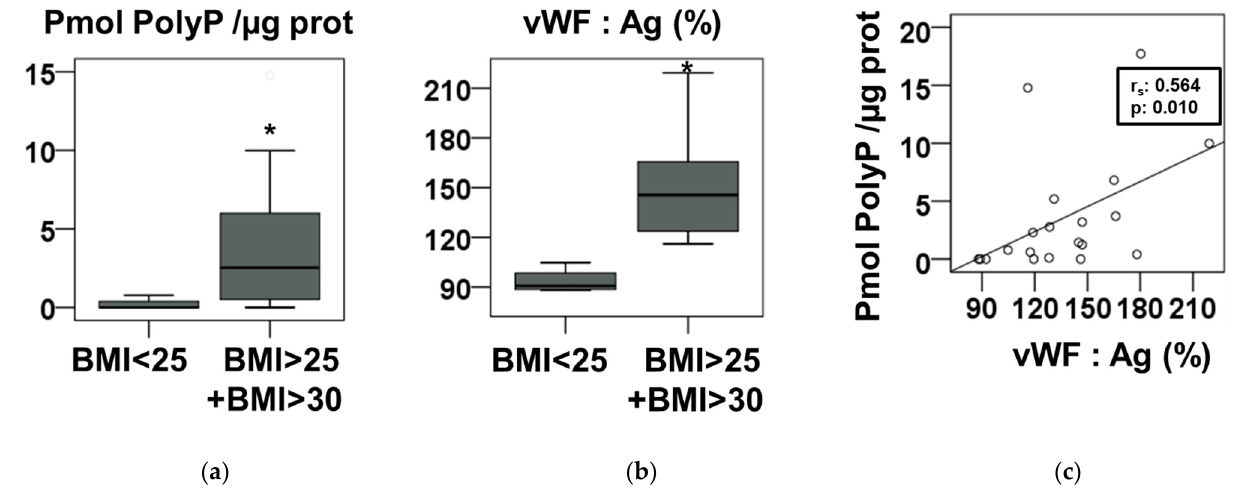
Figure 1. Increased blood plasma polyphosphate levels in children with BMI > 25. ( a ) Plasma polyphosphate (polyP) levels, from individuals described in Table 1, determined by a novel method that used the cryoprecipitated plasma fraction and purified recombinant yeast exopolyphosphatase (described in the Materials and methods section). PolyP concentrations are expressed in terms of phosphate. ( b ) Plasma von Willebrand factor antigen (vWF:Ag), from individuals described in Table 1, as described in the Materials and methods section. In ( a , b ), results are presented in a box-and whiskers plot and the asterisks indicates a statistical difference of p -value < 0.05, determined by Mann–Whitney test. ( c ) Graphic representation and Spearman’s correlation analysis of plasma von Willebrand factor antigen (vWF:Ag) and levels of plasma polyP of all individuals measured in ( a , b ). “r s ”: Spearman’s correlation